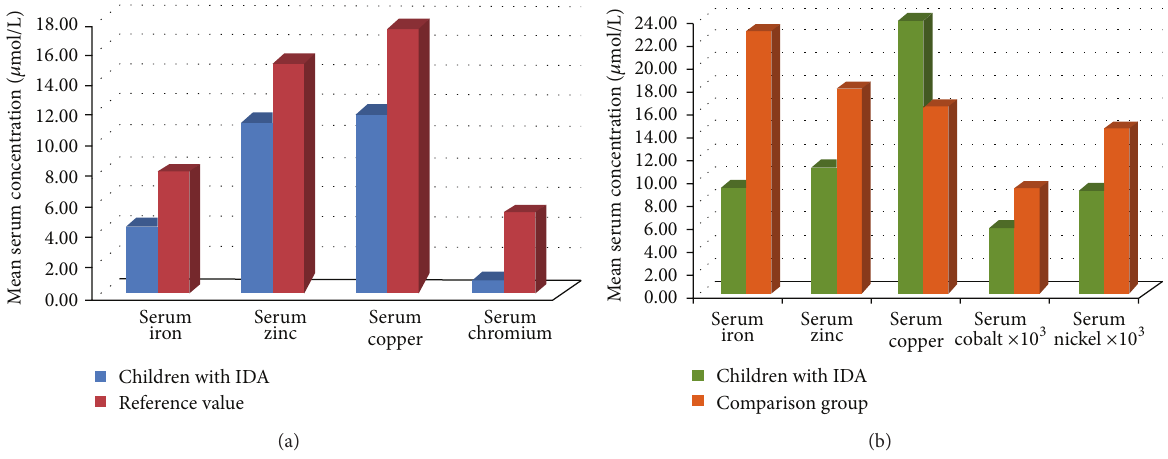
Figure 2: Serum concentrations of trace elements in I group (a) and II group (b) of children with IDA.